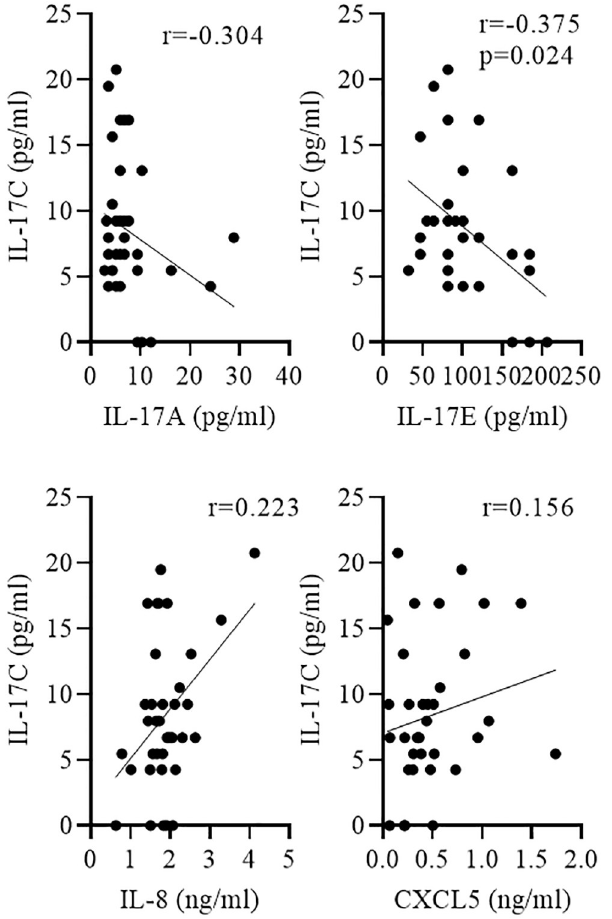
Fig 7. Negative correlation between IL-17C and IL-17E concentrations. Sputum was collected from COPD patients during AECOPD. Correlation of IL-17C with indicated cytokines was tested using nonparametric Spearman’s correlation